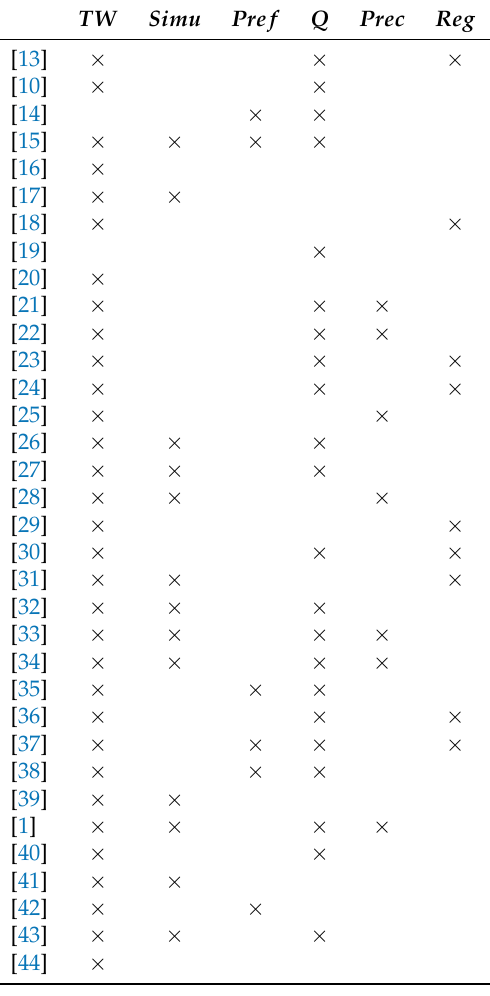
Table 4. Constraints found in the